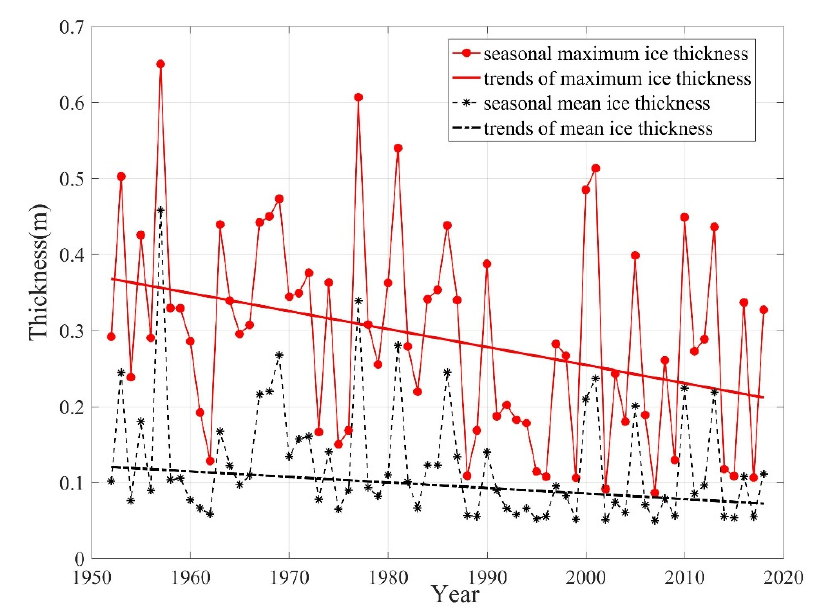
Figure 9. Seasonal evolution of modeled ice thicknesses for 67 ice seasons (1951/1952–2017/2018). The thick black line is the modeled seasonal average ice thicknesses. The color bar represents the ice season in the figure. Table 6. Trends of seasonal ice thicknesses.